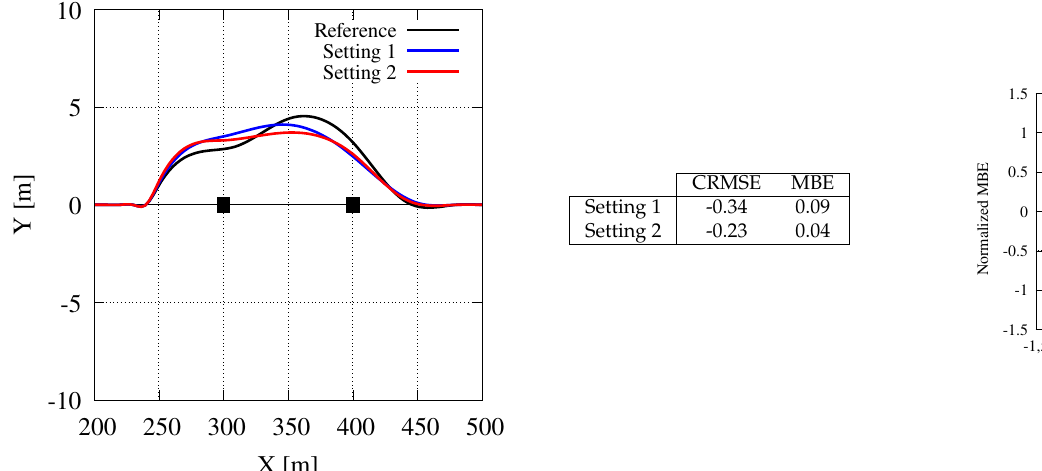
Figure 16. Generated paths for a scenario of a double obstacle avoidance. The CPU trajectory with the setting used by Cabodi et al. [7] (black color) is represented as a reference for the GPU ones (blue and read colors). Notice that in this case, the CPU trajectory is riskier than the ones computed with the GPU as it gets too close to the first obstacle due to slower computation